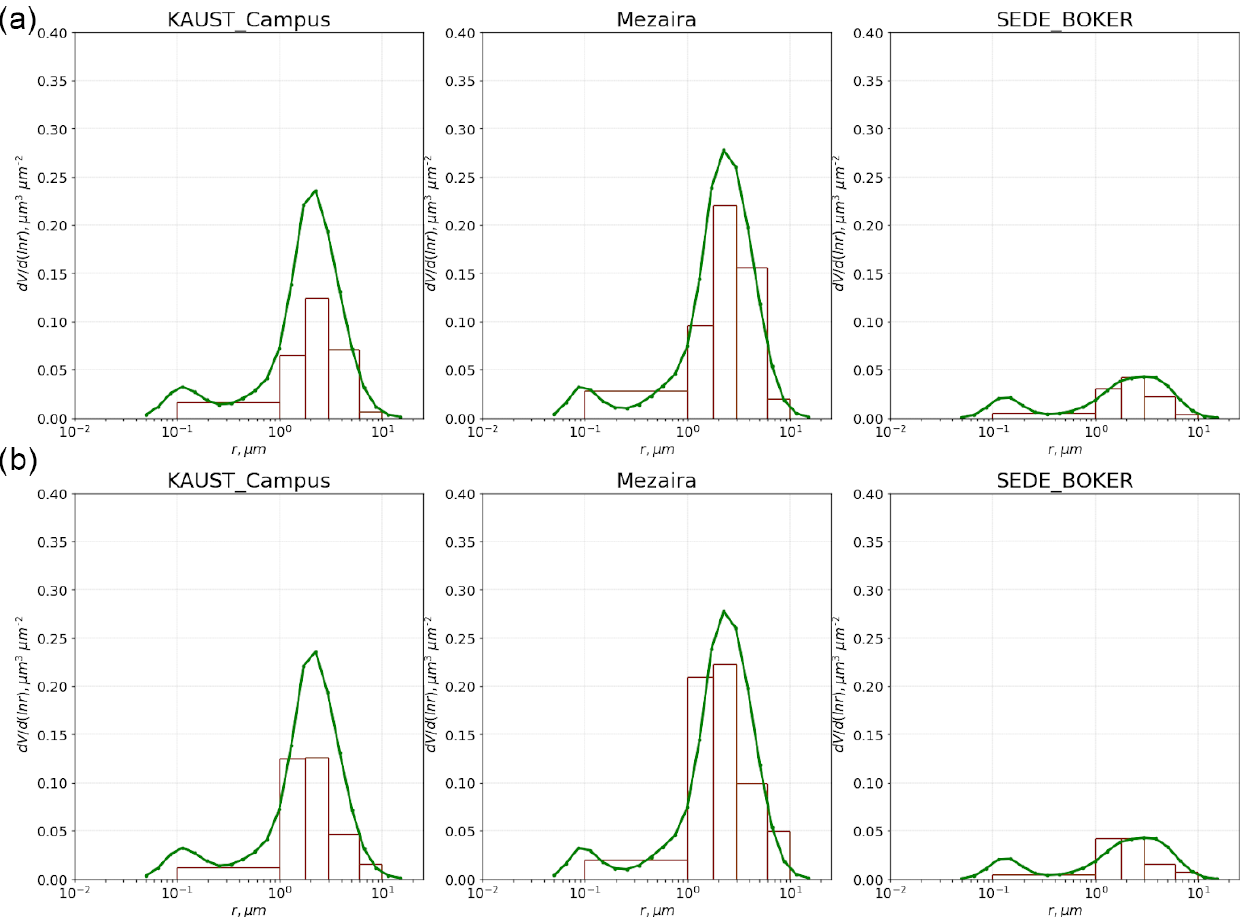
Figure A1. Volume size distributions at KAUST Campus, Mezaira and Sede Boker AERONET sites averaged for JJA of 2015 from WRF-Chem (bars) and from AERONET (solid line): (a) updated s p fractions = { 0 . 15 , 0 . 1 , 0 . 25 , 0 . 4 , 0 . 1 } , (b) default s p fractions = { 0 . 1 , 0 . 25 , 0 . 25 , 0 . 25 , 0 . 25 }